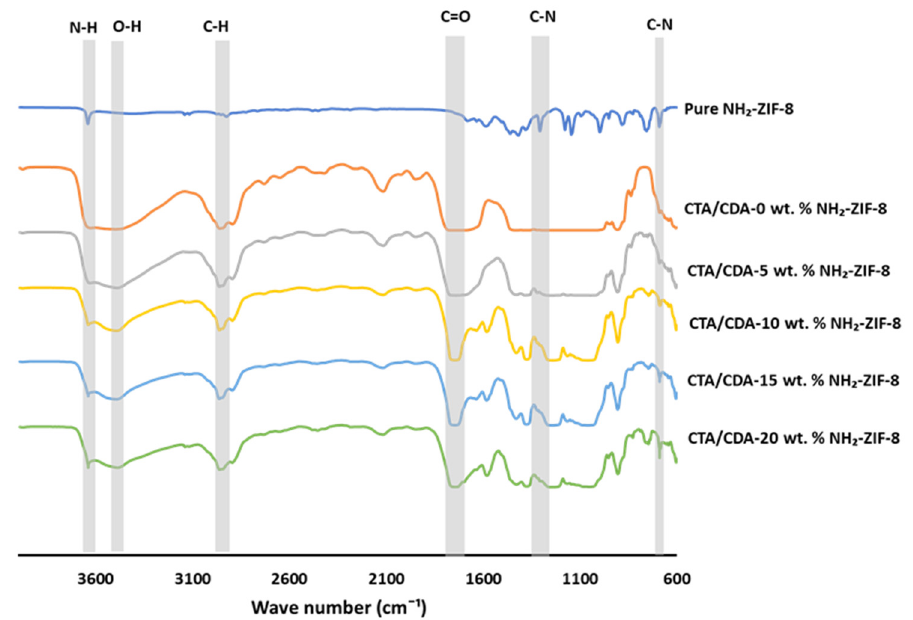
Figure 4. FTIR analyses of pure NH ₂ -ZIF-8 and CTA/CDA-NH ₂ -ZIF-8 MMMs with different NH ₂ - ZIF-8 loadings.